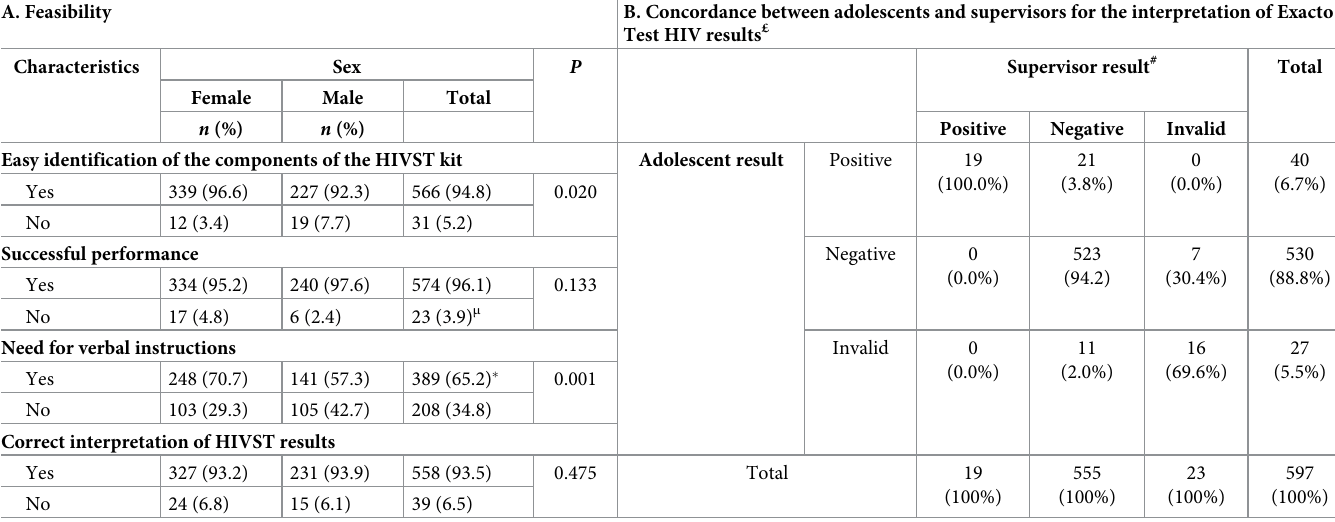
Table 3. Analytical results of the feasibility to use the finger-stick whole blood self-test (Exacto Test HIV Self-test, Biosynex) and obtain a valid result in a home- based, supervised survey among 597 adolescents living in Kisangani.